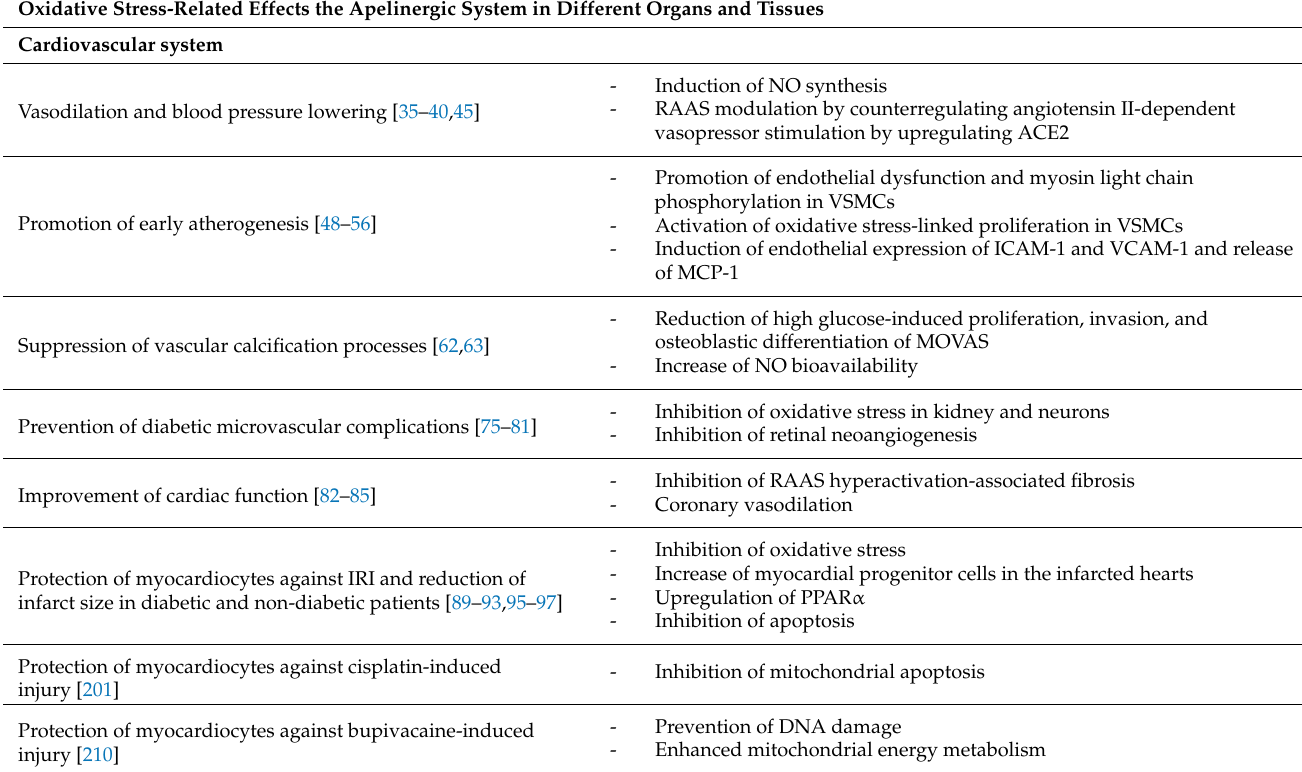
Table 1. Biological actions of the apelinergic system oxidative stress-related